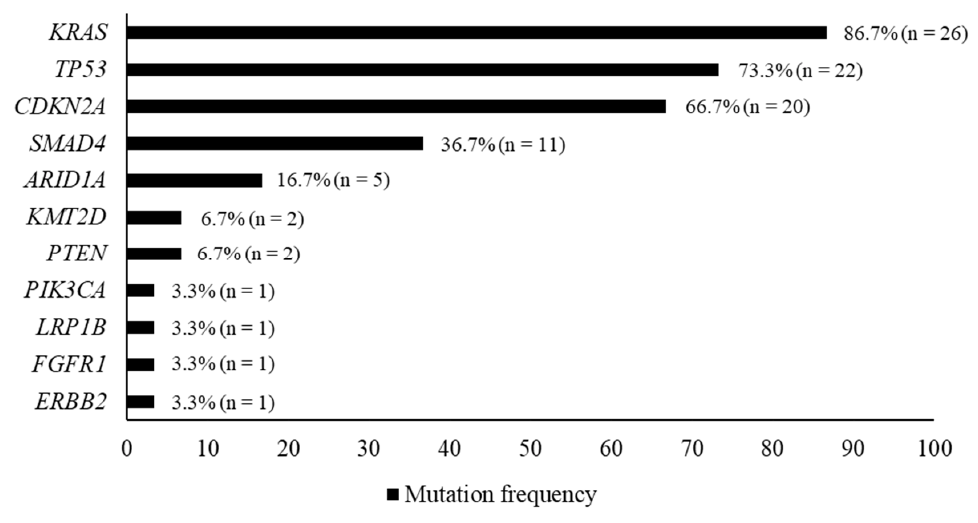
Figure 3. Frequency of mutations identified with genomic testing of 30 patients. Table 3. VAF rate of each sample in successful NGS.